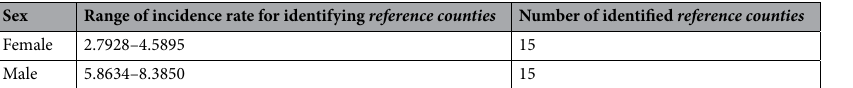
Table 6. The final determining ranges, in terms of the incidence rate, for identifying reference counties .